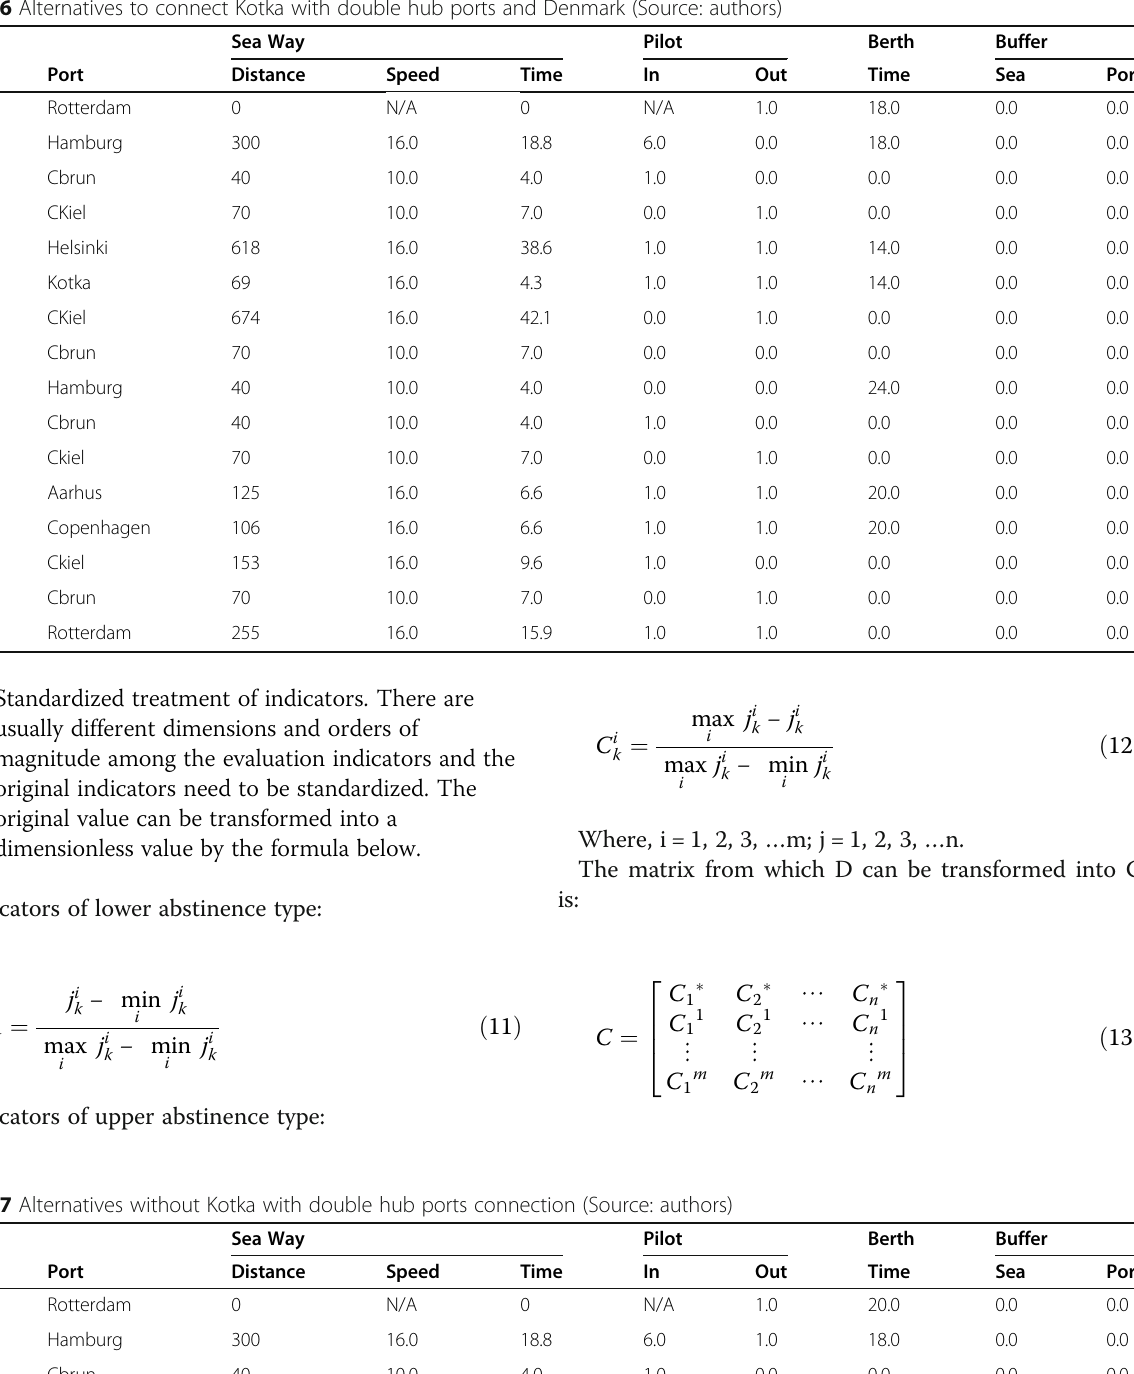
Table 6 Alternatives to connect Kotka with double hub ports and Denmark (Source: authors) Sea Way Pilot Berth Buffer No.